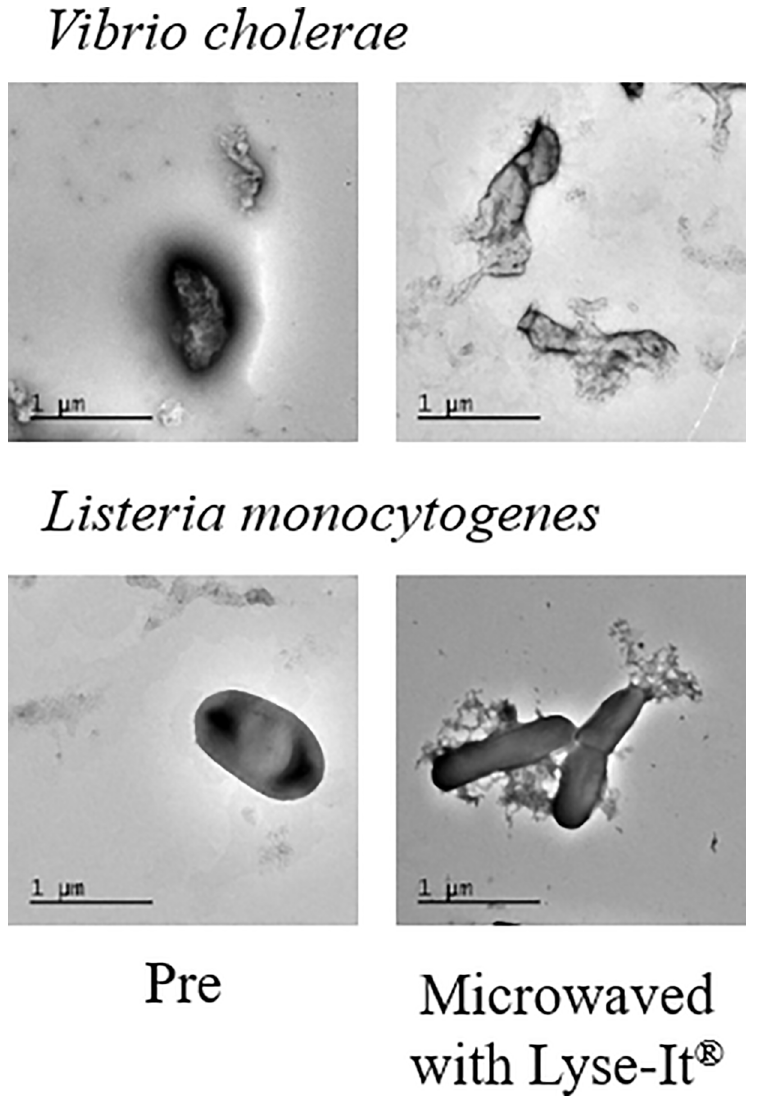
Fig 1. TEM images representing microwave cellular lysis. Left: Before microwave heating. Right: After microwave heating. V . cholerae was microwaved at 30% power (270 watts) for 60 seconds. L . monocytogenes was microwaved at 50% power (450 watts) for 60